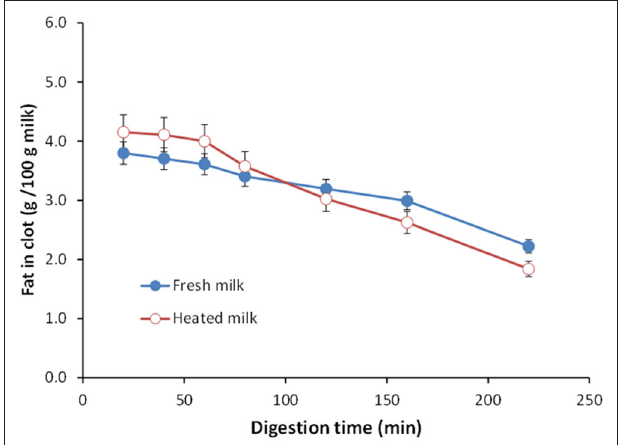
FIGURE 4 | Changes in the fat content (g/100g milk) in clots obtained from (•) unheated (raw) and ( ◦ ) heated cattle whole milk during gastric digestion. Source: Adapted from Ye et al.